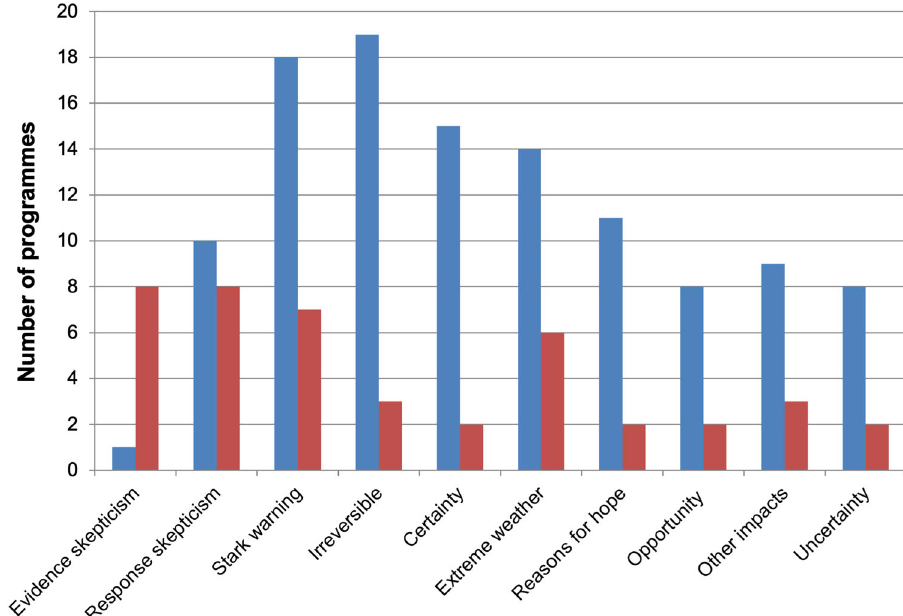
Fig. 4 Relative presence of discourses in mainstream and right-wing channels. Mainstream channels in blue and right-wing channels in